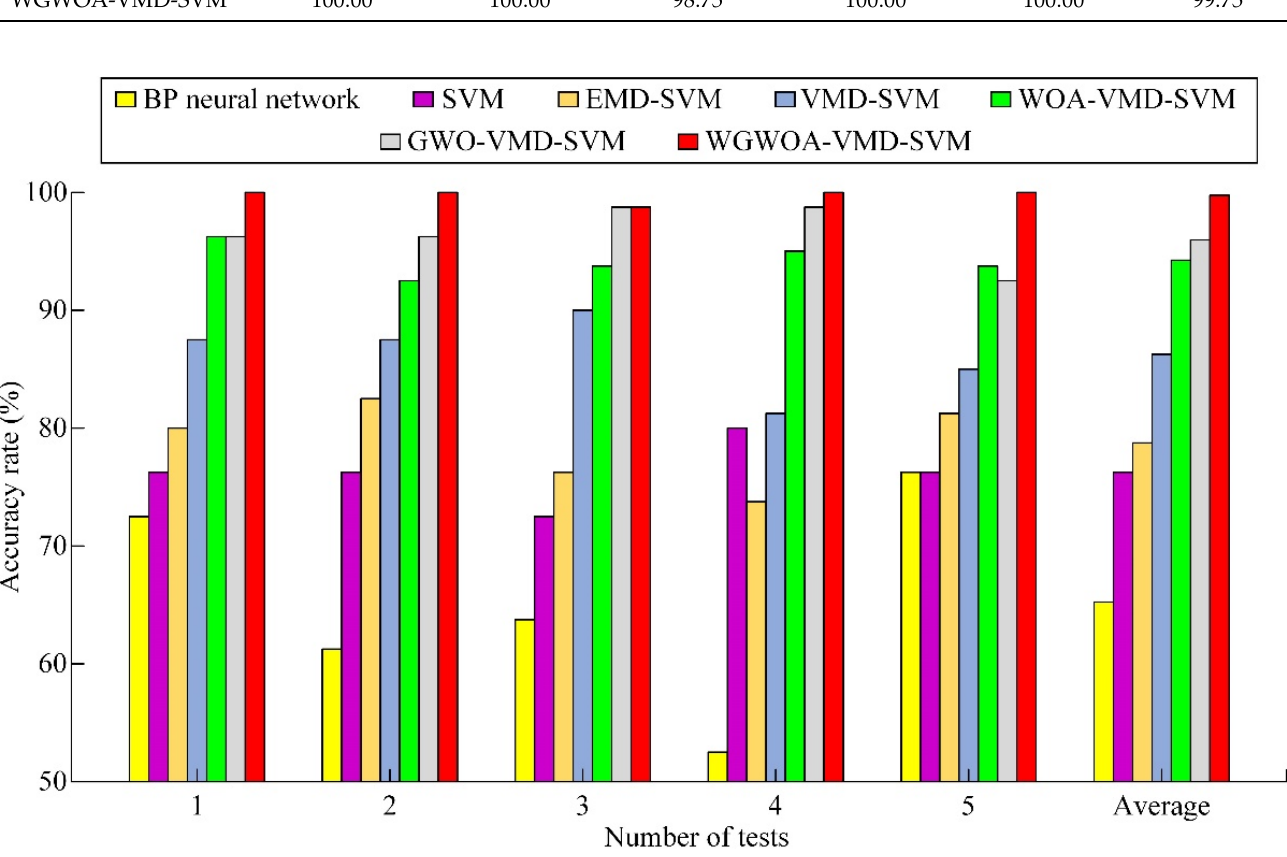
Figure 16. Test diagnostic accuracy. Table 8. Diagnostic accuracy of different method